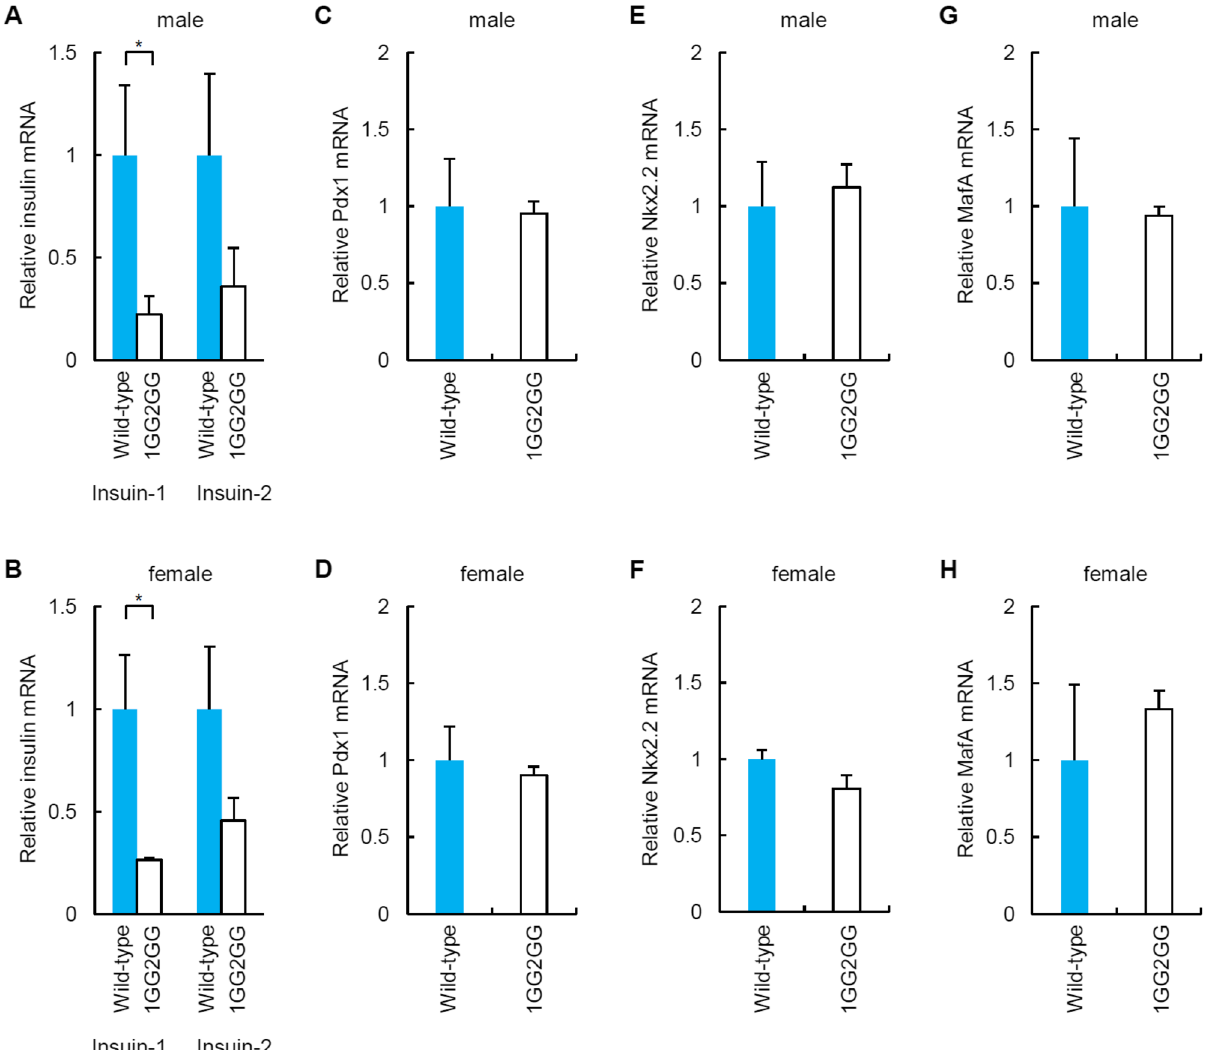
Figure 5. Ins1/2, Pdx1 , Nkx2.2, and MafA mRNA levels in pancreatic islets from 1GG2GG mice. ( A , B ) qRT- PCR analysis of Ins1 and Ins2 in pancreatic islets of 1GG2GG mice [( A ): male, ( B ): female]. ( C , D ) qRT-PCR analysis of Pdx1 expression in pancreatic islets of 1GG2GG mice [( C ): male, ( D ): female]. ( E , F ) qRT-PCR analysis of Nkx2.2 expression in pancreatic islets of 1GG2GG mice [( E ): male, ( F ): female]. ( G , H ) qRT-PCR analysis of MafA expression in pancreatic islets of 1GG2GG mice [( G ): male, ( H ): female]. Pancreatic islets (purity > 95%) of wild-type mice served as a control. The data are expressed as the gene-to- Gapdh ratio; that of the control cells was arbitrarily defined as 1 (n = 8). The error bars represent the standard error. * p <